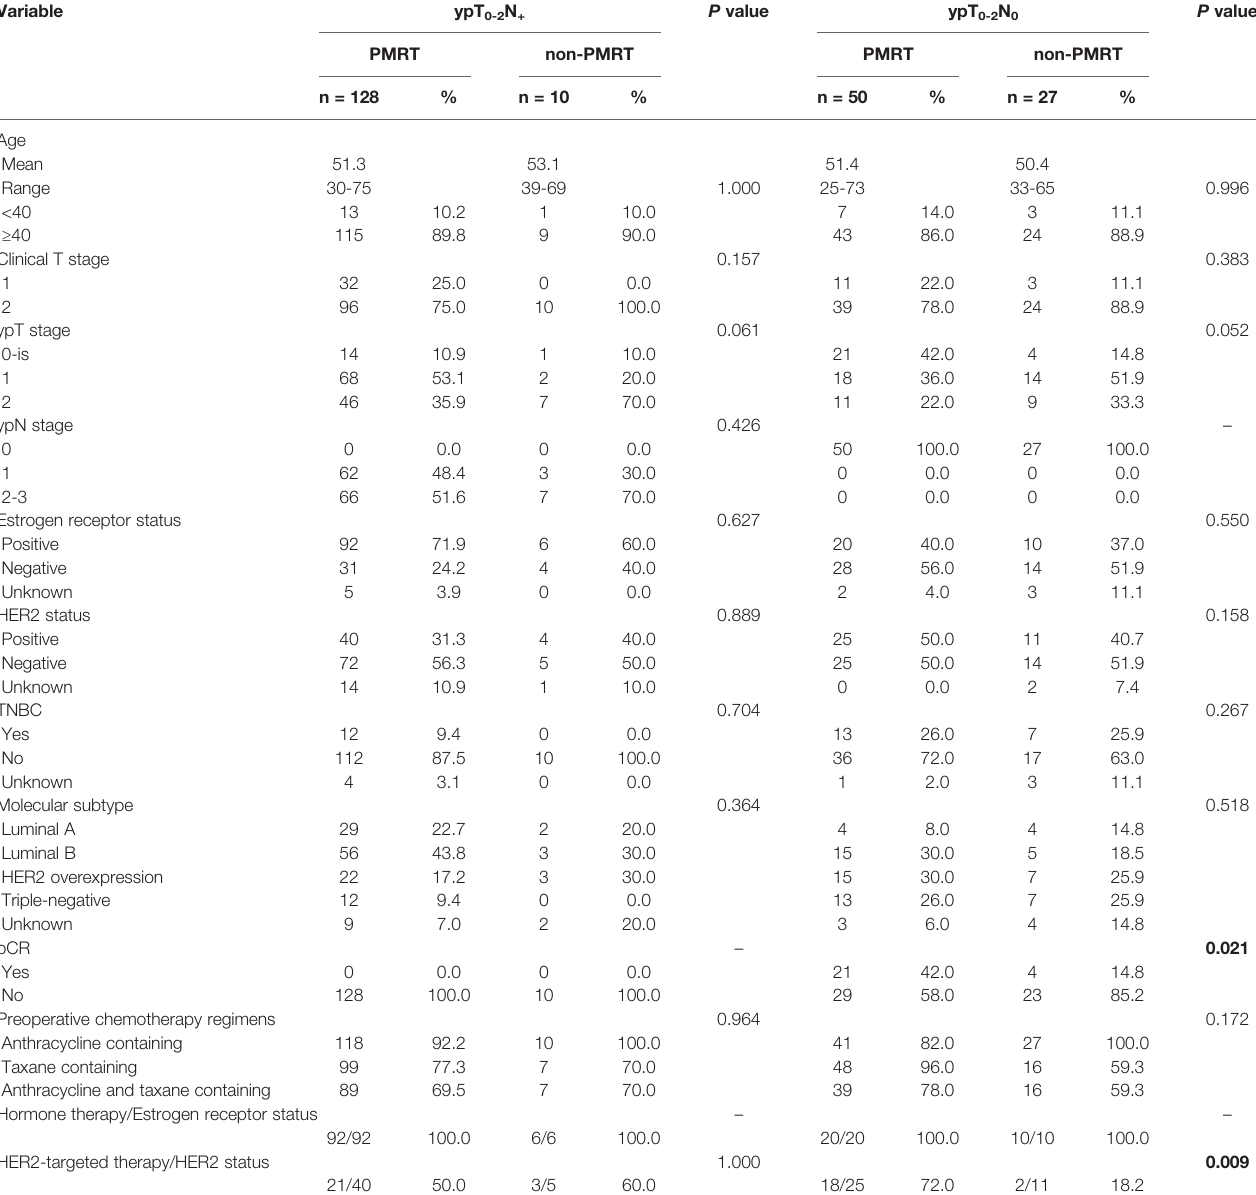
TABLE 2 | Clinical characteristics of patients in the ypT 0-2 N 0 PMRT and non-PMRT subgroups. Variable ypT 0-2 N